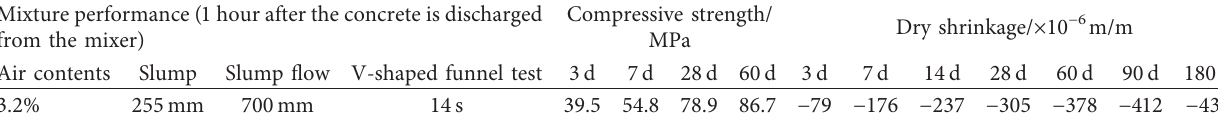
Table 2: Major parameters of massive self-compacting concrete pumped in steel tube columns.